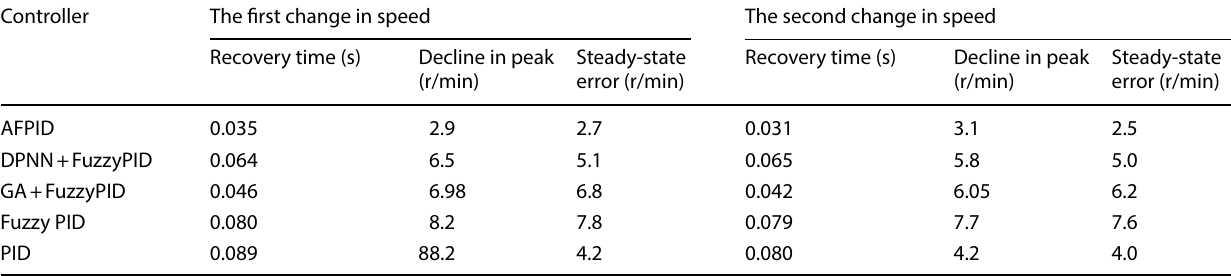
Table 6 The performance indexes under the condition of continuously varying speeds